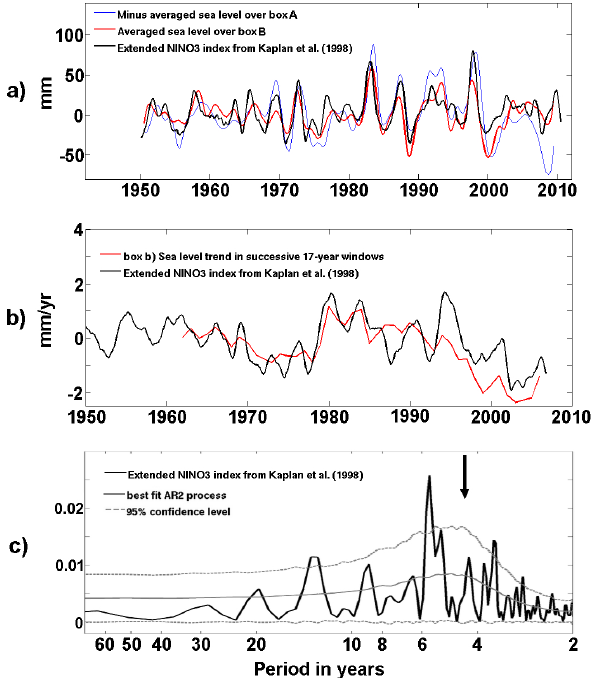
Fig. 4. (a) : Minus spatial averaged sea level over box A in blue, spatial averaged sea level over box B in red, and NINO3 index in black. Time series have been smoothed with a 1-yr running mean. The NINO3 index is normalised in amplitude. (b) : Spatial average of sea level trends of box B computed over successive 17-yr win- dows in red. NINO3 index in black, filtered with a 10-yr running mean. Before computation, the spatially averaged sea level trend has been removed from the sea level time series. NINO3 index has been detrended over the period as well and normalised in amplitude. (c) : NINO3 index (Kaplan et al., 1998) power spectrum (in black) and the best fit AR2 process in grey as the null hypothesis. The grey dash lines indicate the 95% confidence level around the null